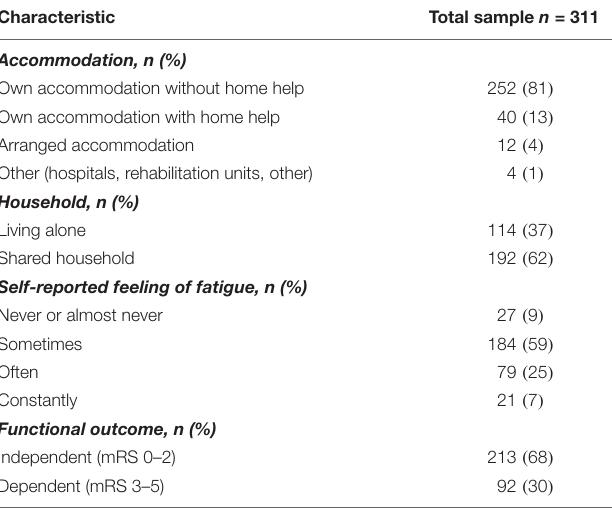
TABLE 2 | Characteristics of the 311 study participants 3 months after a stroke.